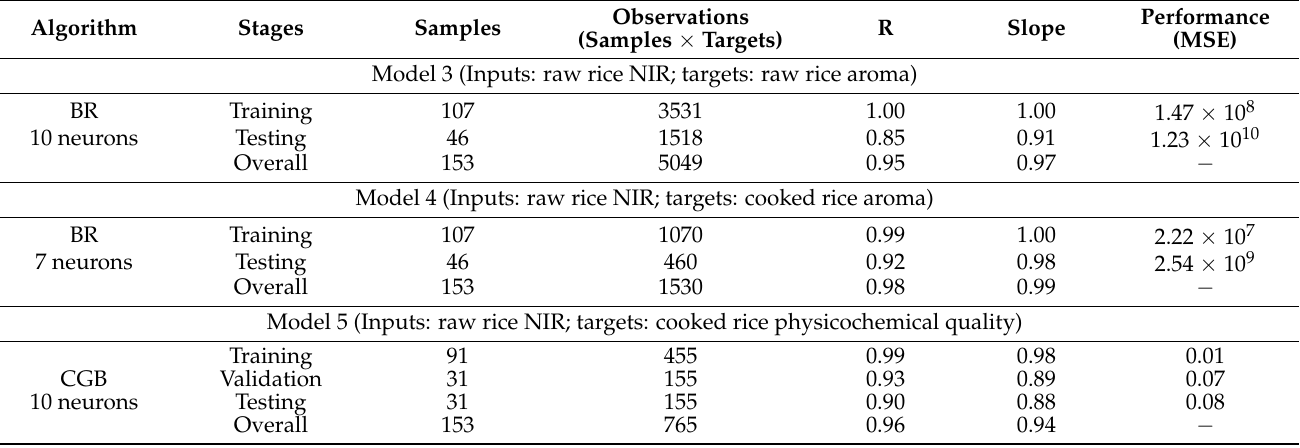
Table 4. Statistical results of the artificial neural network regression models developed using the first derivative of near-infrared absorbances (Model 3–Model 5) and electronic nose measurements (Model 6 and Model 7) as inputs to predict rice quality. Abbreviations: BR: Bayesian regularization; CGB: conjugate gradient with Powell–Beale restarts; LM: Levenberg–Marquardt; R: correlation co-